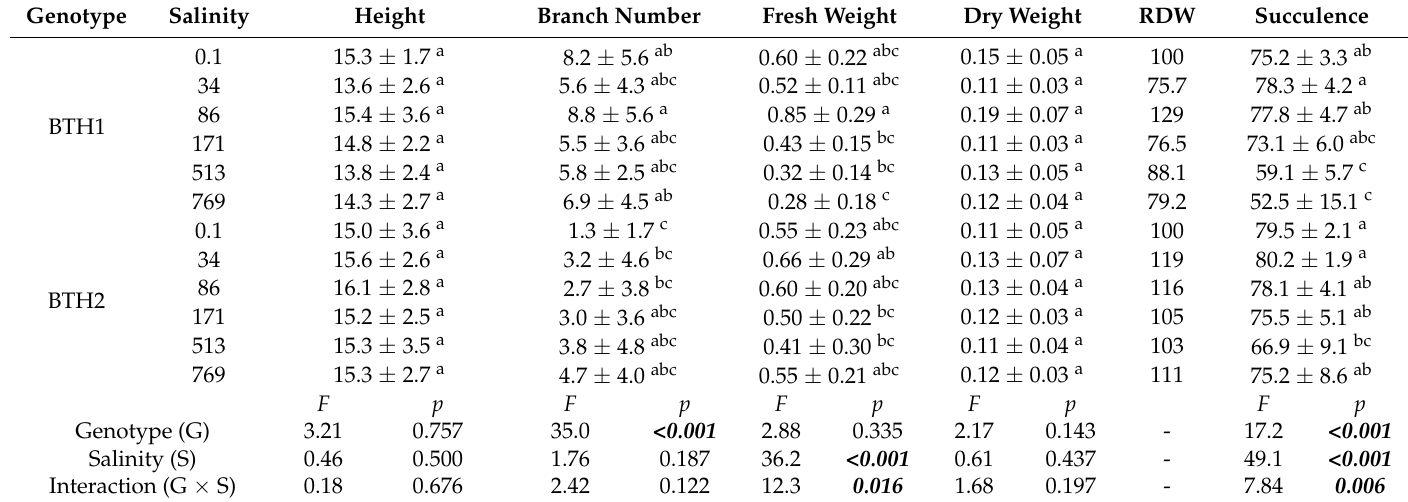
Table 2. Averages ( ± standard deviation) of height (cm), branch number, fresh weight (g), dry weight (g), relative shoot dry weight (RDW; % of the average biomass of plants grown at 0 mM NaCl) and succulence (%) of Salicornia neei genotypes (BTH1 and BTH2) after 50 days of cultivation in greenhouse at different salinities (0.1, 34, 86, 171, 513 and 769 mM